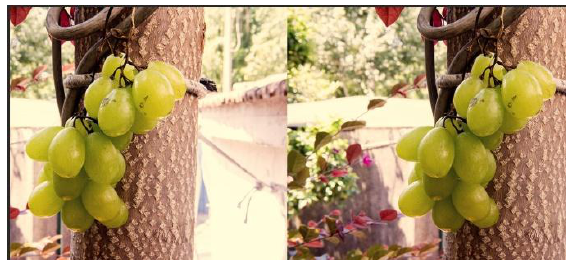
Figure 12. Stereoscopic images of a MPO file